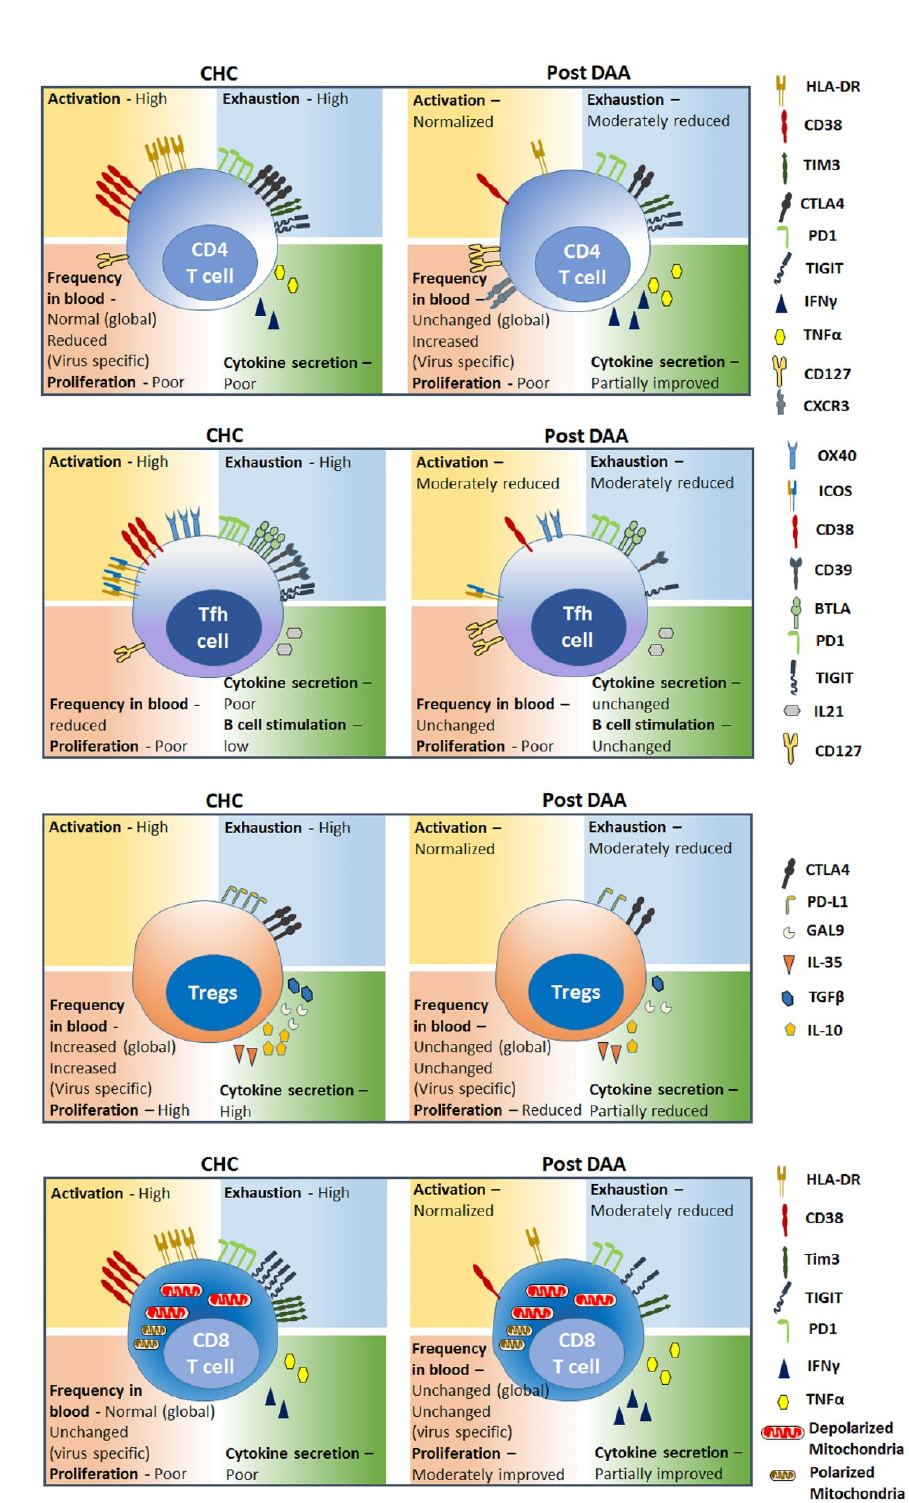
Figure 1. Visual summary of perturbations in frequency, phenotypes, and function of innate ( A ) and adaptive ( B ) lymphocytes in chronic hepatitis C virus (HCV) (CHC) patients and restoration associated with direct acting antiviral (DAA)-mediated viral clearance.